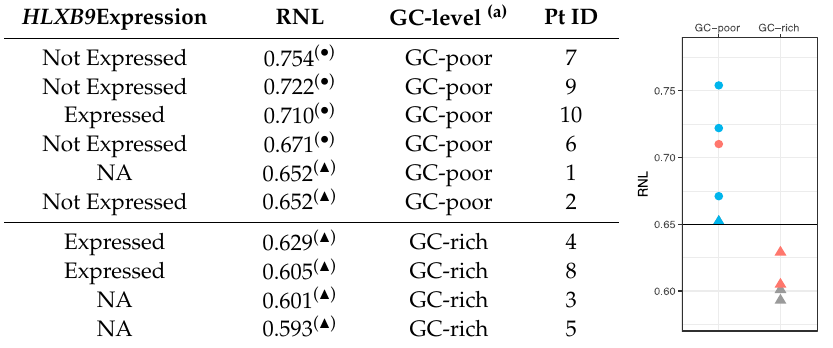
Figure 7. Detection of the HLXB9 transcript in patient samples with del(7q). Agarose gel electrophoresis containing nested reverse transcription (RT)-PCR products obtained using primers specific for HLXB9 . The molecular marker (M) is peqGOLD DNA-Sizer XI (range 67-1118 bp, PeqLab, Fareham, UK). The amplified DNA fragment, indicated by black arrows, corresponds to theexpected size of the HLXB9 transcript (359 bp). The transcript is clearly present in Pt-4, Pt-8 and Pt-10. Positive controls are the leukemia-derived cell line K562 and another patient sample (Cnt+), known to express HLXB9 (patient no. 10 in [38]). Table 3. HLXB9 gene positioning and expression in the patients analyzed in this study.